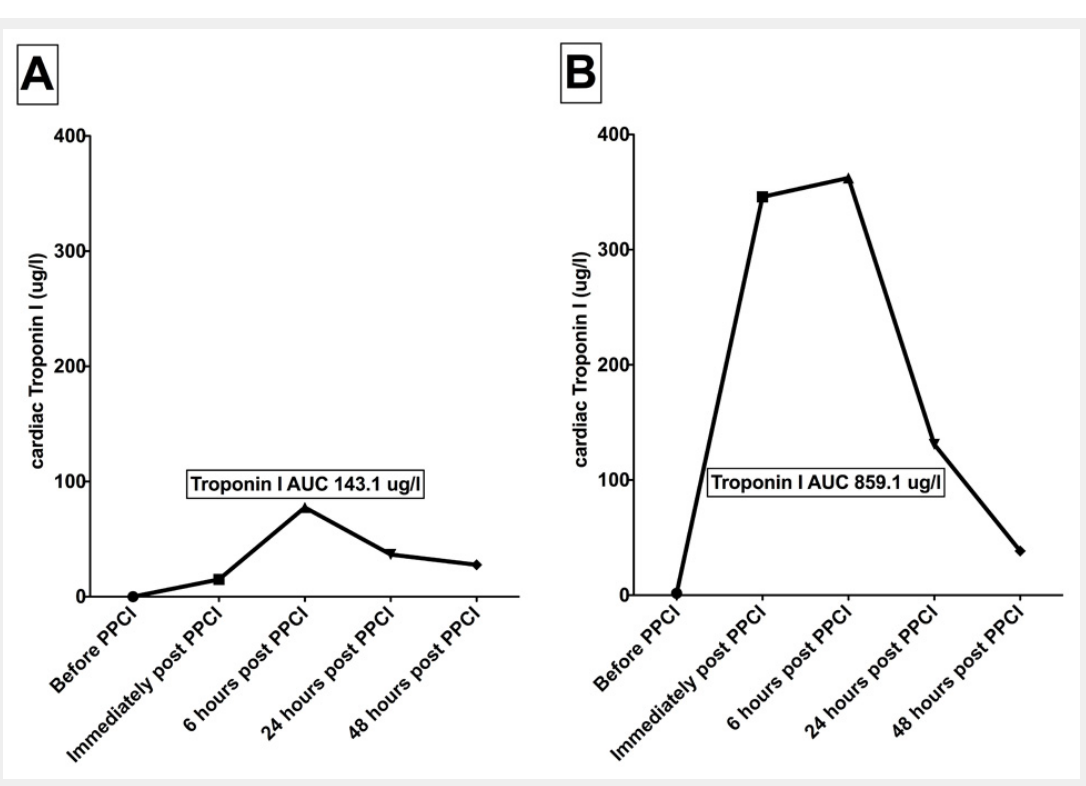
Figure 1 Troponin I curves of two patients with anterior ST-elevation myocardial infarction Both patients had occlusion of the proximal left anterior descending artery and similar symptom-to-balloon times. The ECGs of patient A are presented in figure 2A and the ECGs of patient B are presented in figure